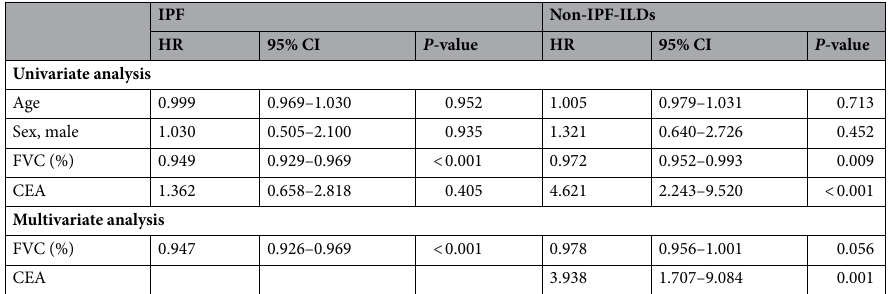
Table 4. Prognostic factor for mortality according to the specific diagnosis. HR hazard ratio, CI confidence interval, IPF idiopathic pulmonary fibrosis, ILD interstitial lung disease, PFT pulmonary function test, FVC forced vital capacity, ILD interstitial lung disease, CEA carcinoembryonic